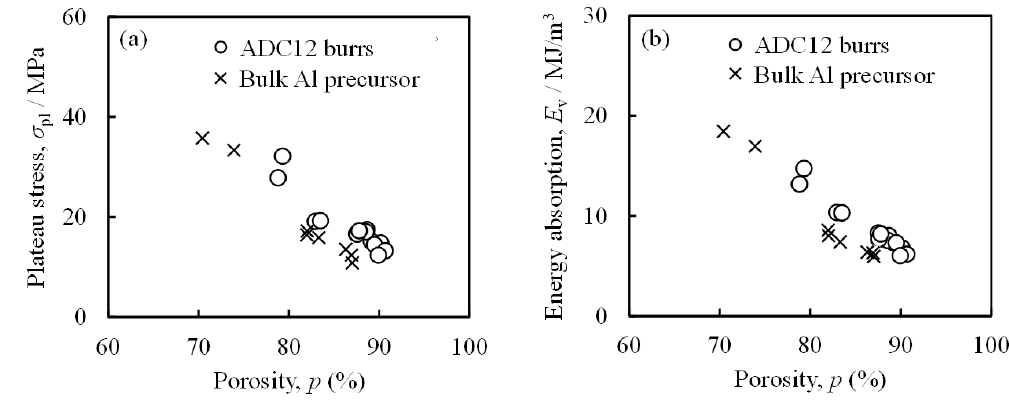
Figure 10. Relationship between ( a ) plateau stress σ pl and ( b ) energy absorption per unit volume E V and porosity p for the obtained Al foam-filled steel tubes fabricated from ADC12 burrs along with those fabricated from the bulk Al precursor.